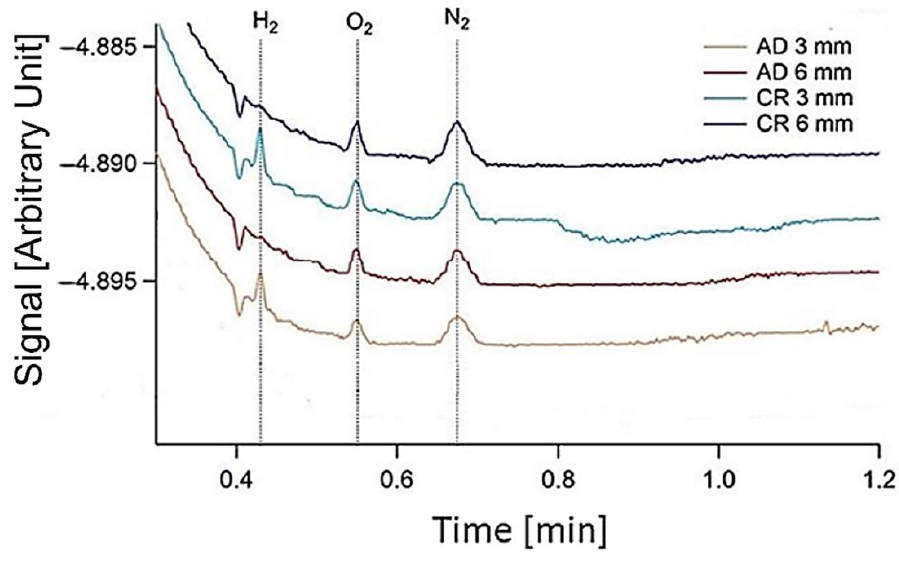
Figure 6. Permeability test chromatogram.